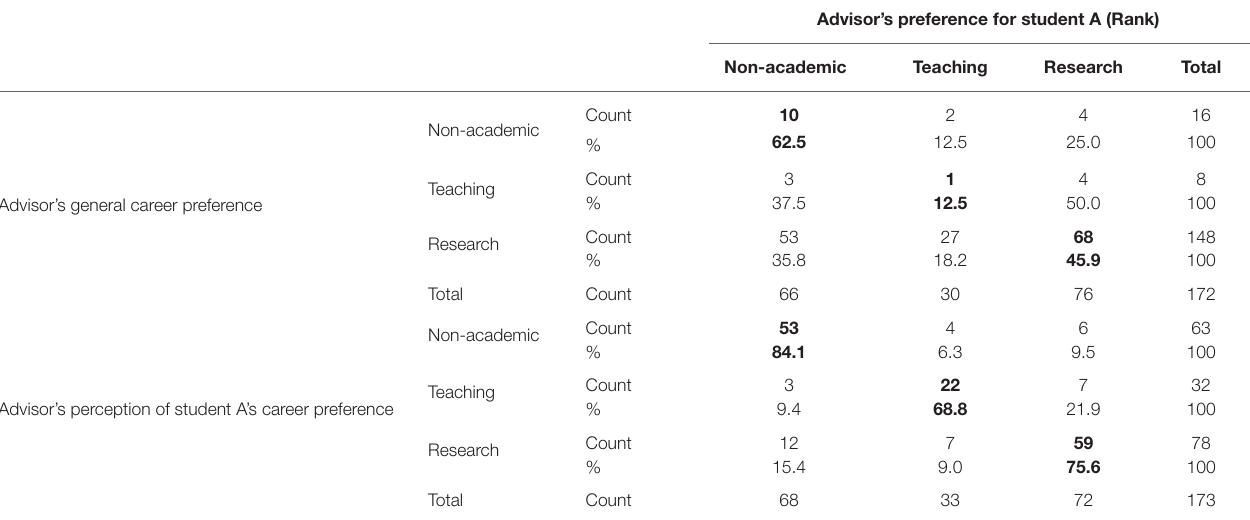
TABLE 6 | Advisor’s own career preference for students in general and advisors’ perception of student A’s (most senior PhD student’s) career